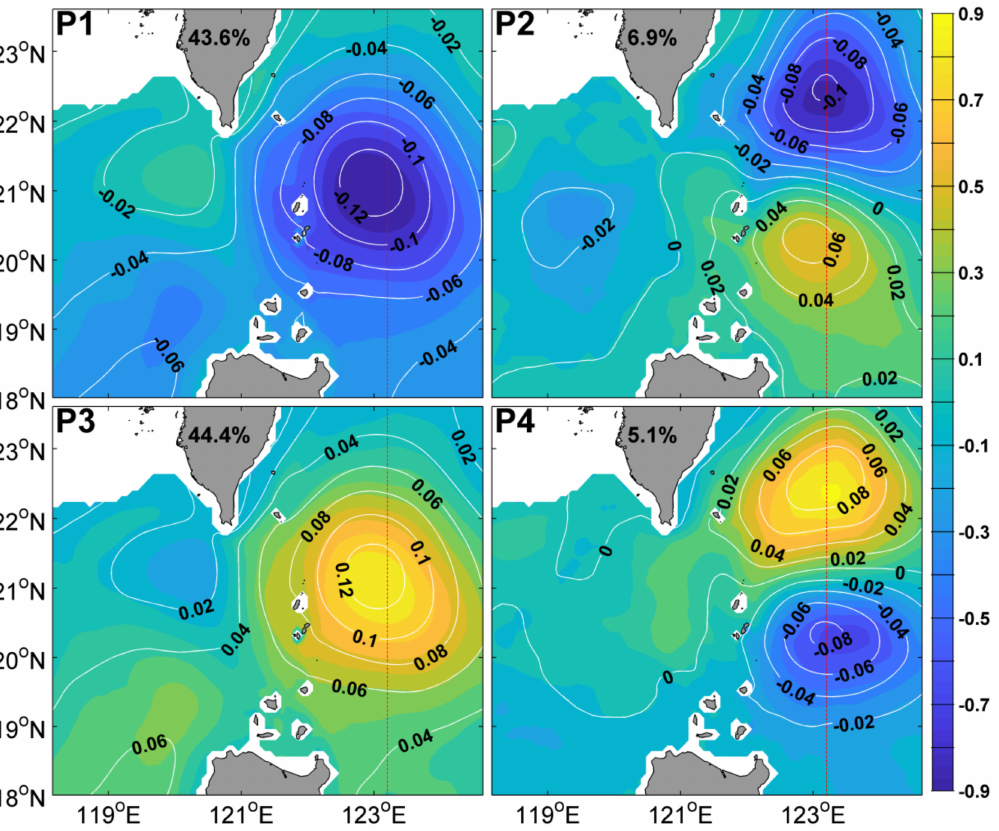
Figure 3. The 2 × 2 SOM patterns derived from the HYCOM SSH fields for the east branch, and corresponding sea temperature anomaly in 300 meters deep. Sea Surface Height Anomaly (SSHA) (m, in contour); Sea temperature ( ◦ C, in color). The number on each panel represents the occurrence rate of corresponding pattern. The red dotted line represents meridional section of sea temperature, and its longitude is 123.2 ◦